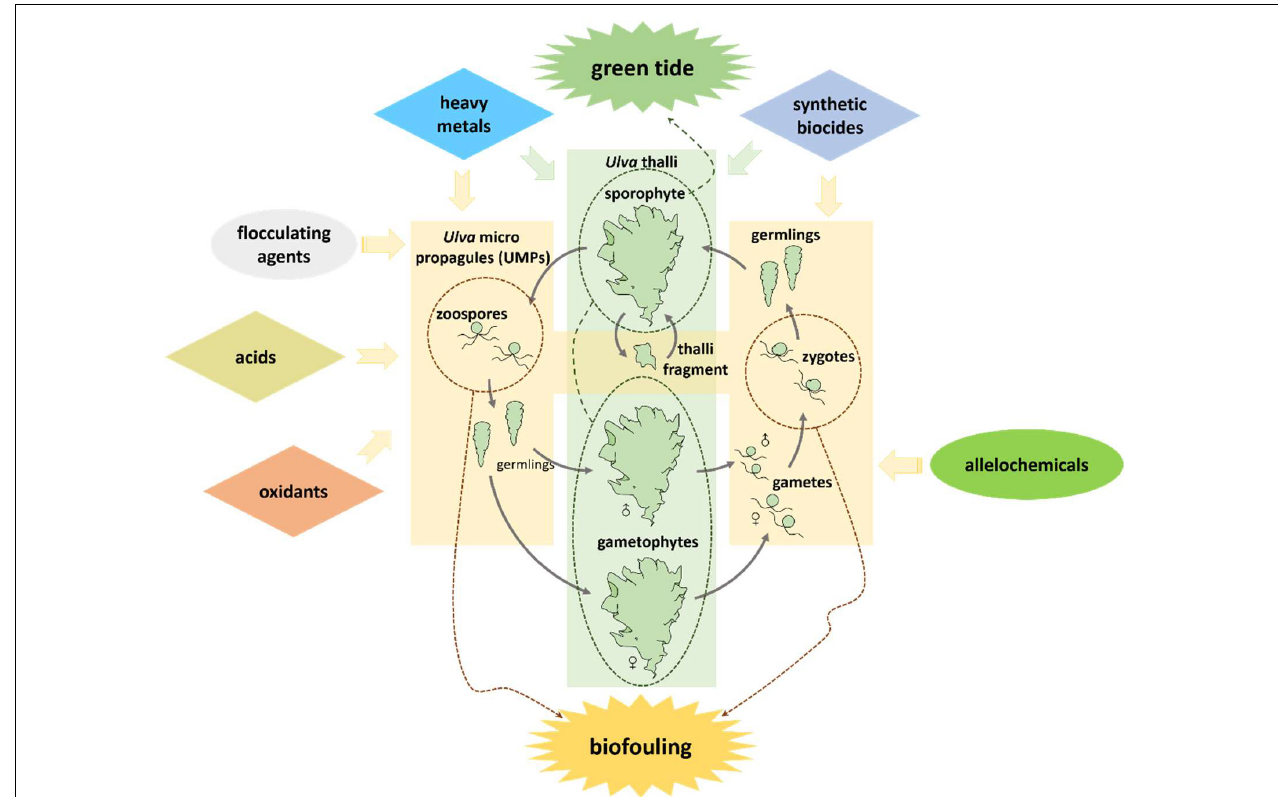
FIGURE 1 | Key chemical approaches to kill or inhibit Ulva in the typical life